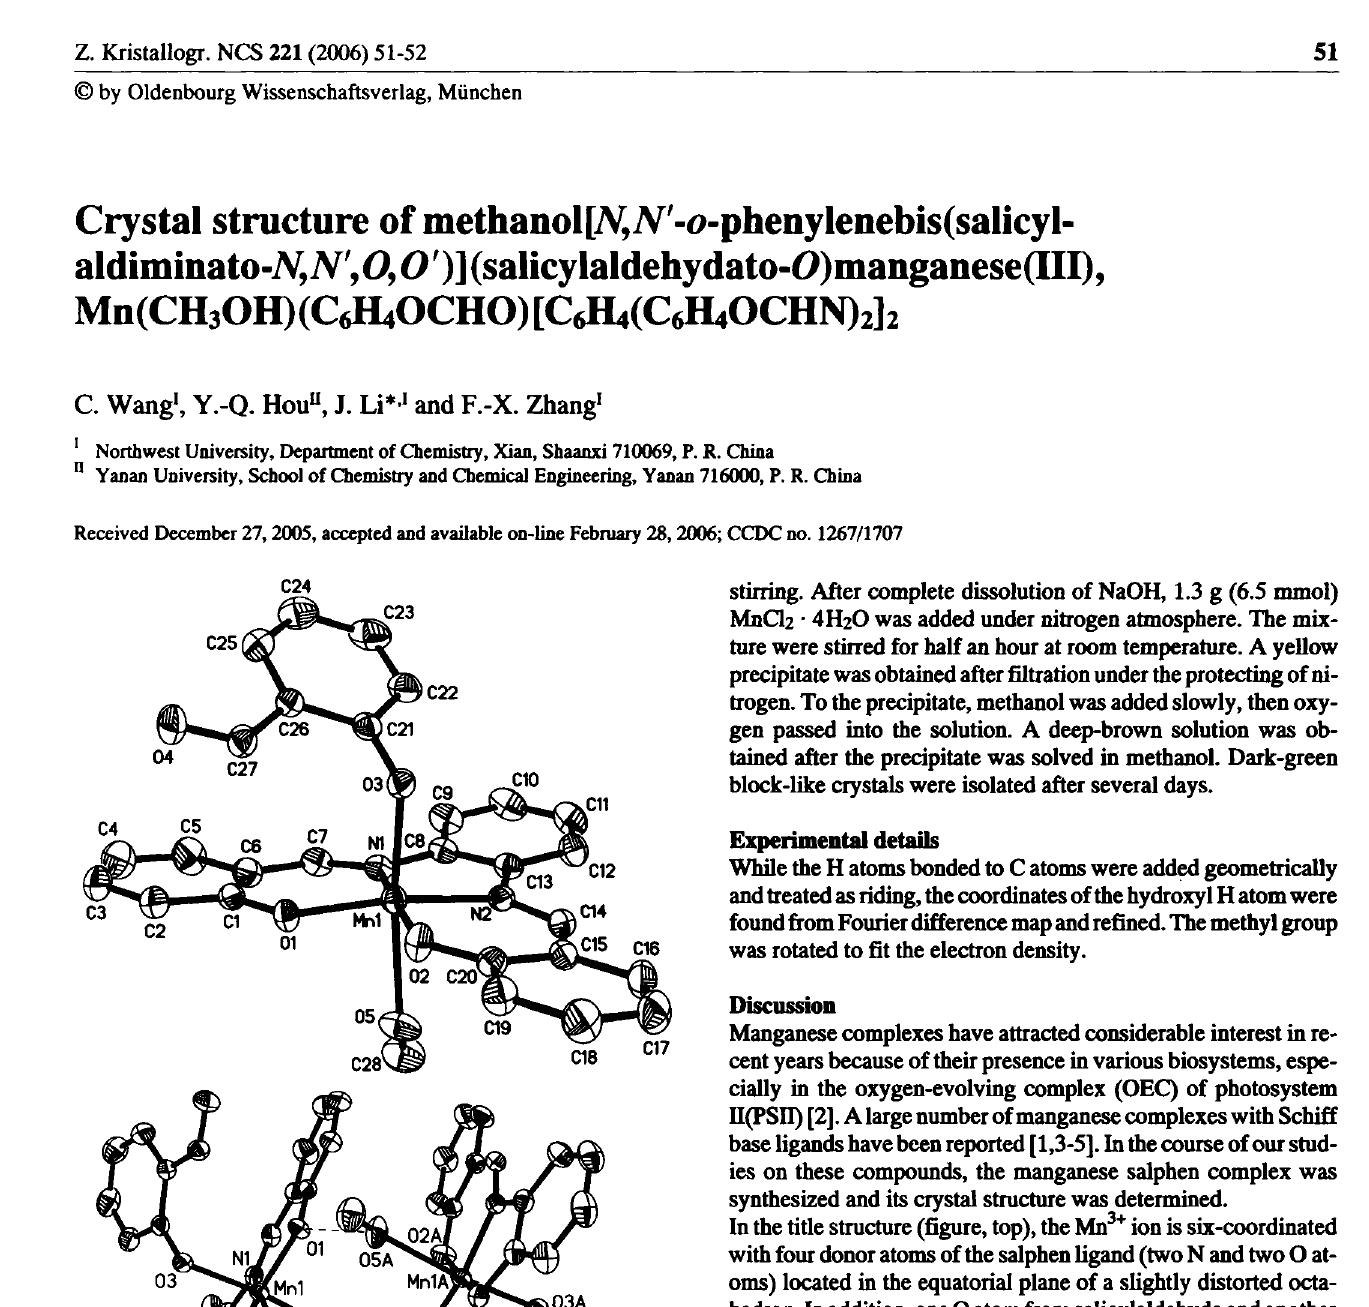
Table 1. Data collection and